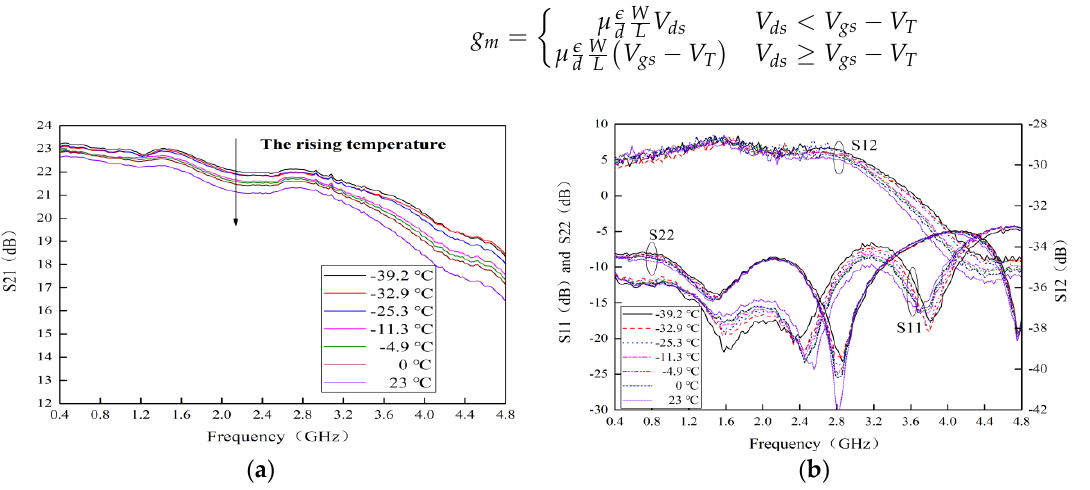
Figure 8. Measured curves of S-parameters with typical alpine temperatures. ( a ) S21 ( b ) S11, S12 and S22.